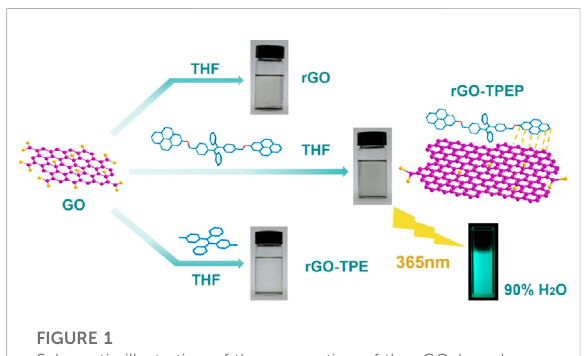
FIGURE 1 Schematic illustration of the preparation of the rGO-based